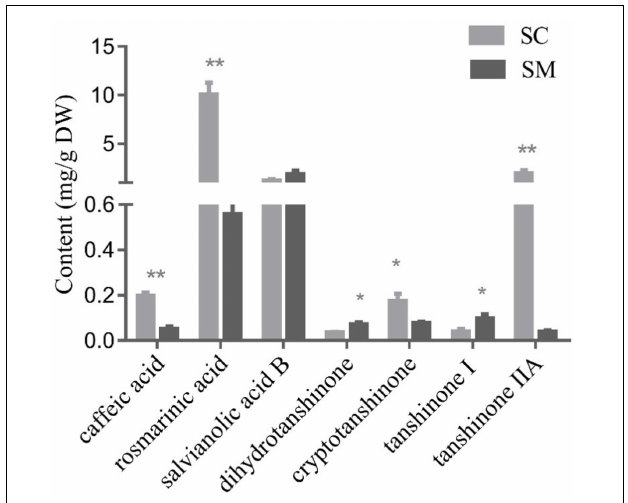
FIGURE 1 | Contents of tanshinones and polyphenolic compounds in Salvia miltiorrhiza and Salvia castanea hairy roots. HPLC analysis of phenolic acids and tanshinones in S. miltiorrhiza and S. castanea hairy roots. Error bars represent the standard deviation (SD, n = 3 biologically independent samples; “*” represents 0.01 < p < 0.05, “**” represents p <